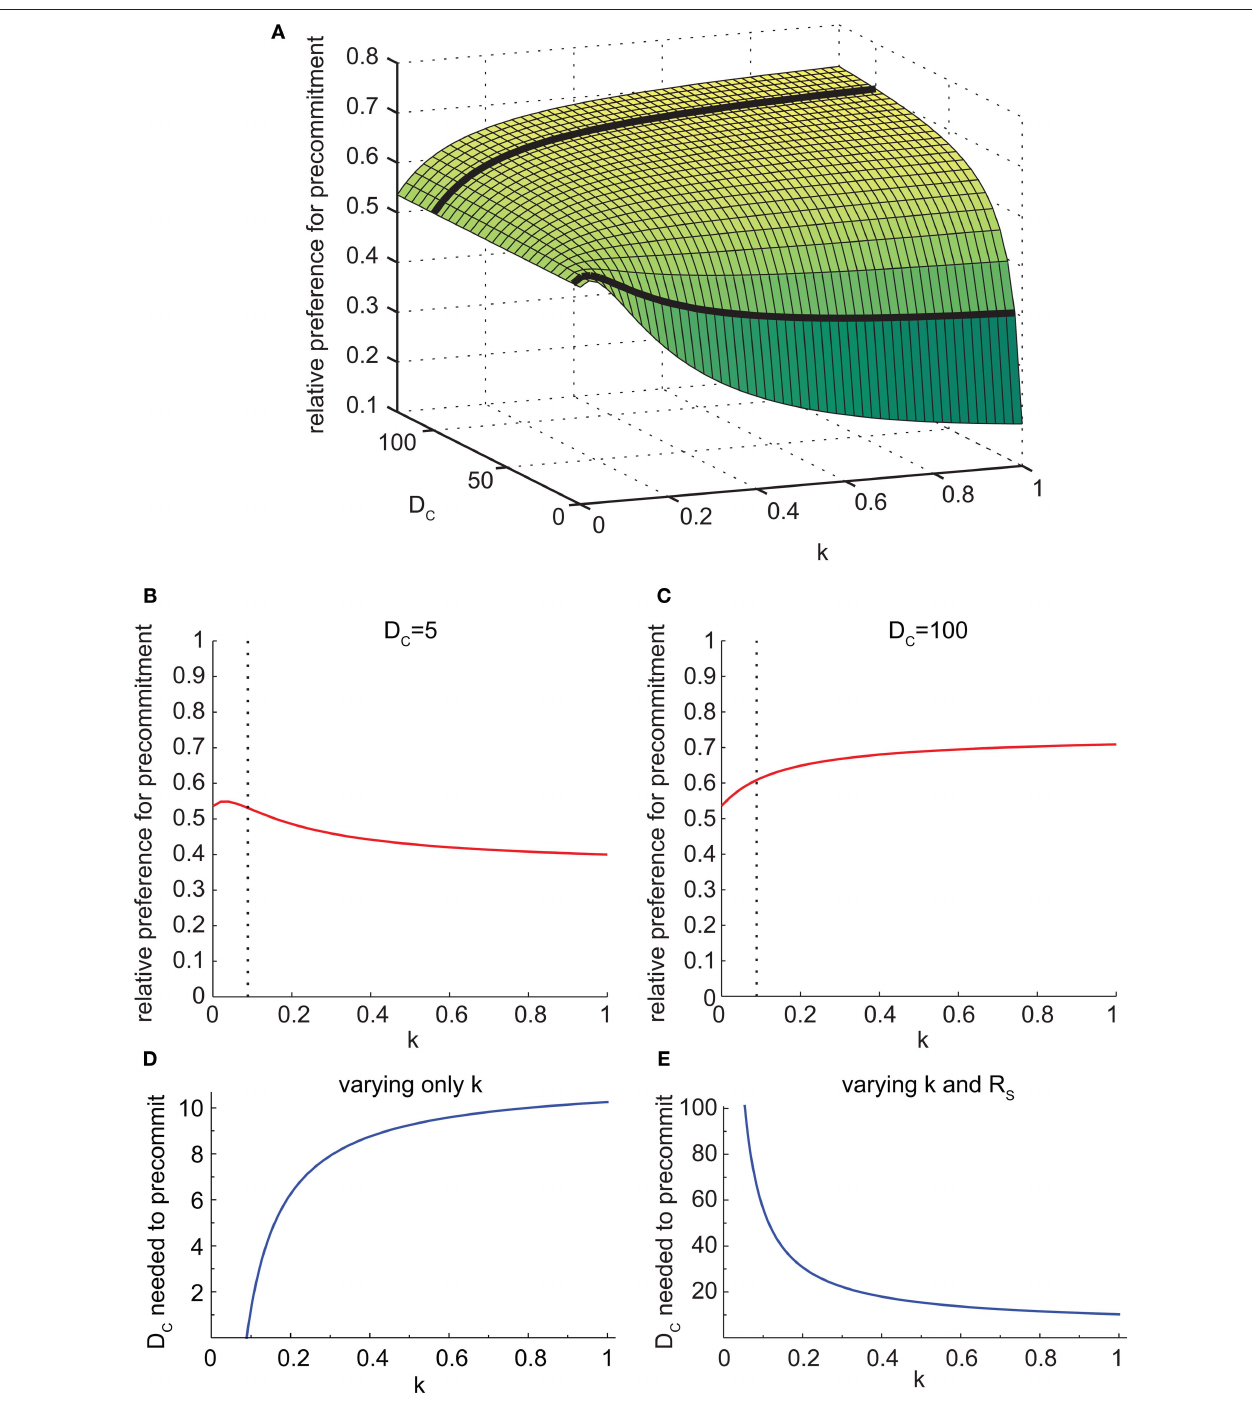
precommitment also increased. Faster discounting increased the amount of D required to produce precommitment. When k was less than 4/45, LL was C preferred over SS, so N was preferred over C even when there was no = 5 and C precommitment delay. (e) The SS–LL preference ratio was held constant by C adjusting R . Under this condition, the amount of D S grew as k increased. In other words, for a given SS–LL preference, agents with slower discounting will require a much longer D precommitment. This figure was generated with mathematical hyperbolic required to prefer C